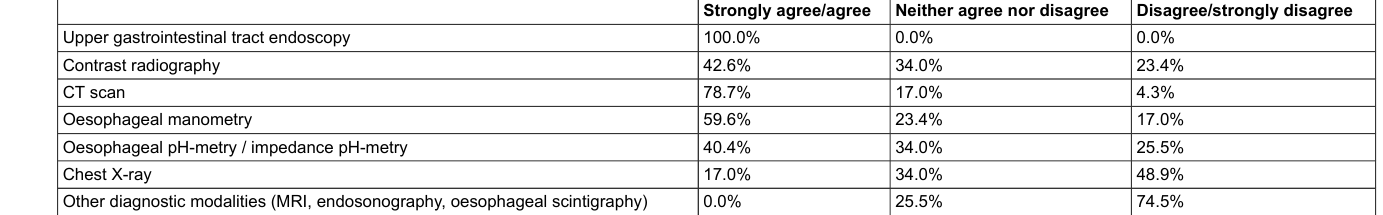
Strongly agree/agree Neither agree nor disagree Disagree/strongly disagree